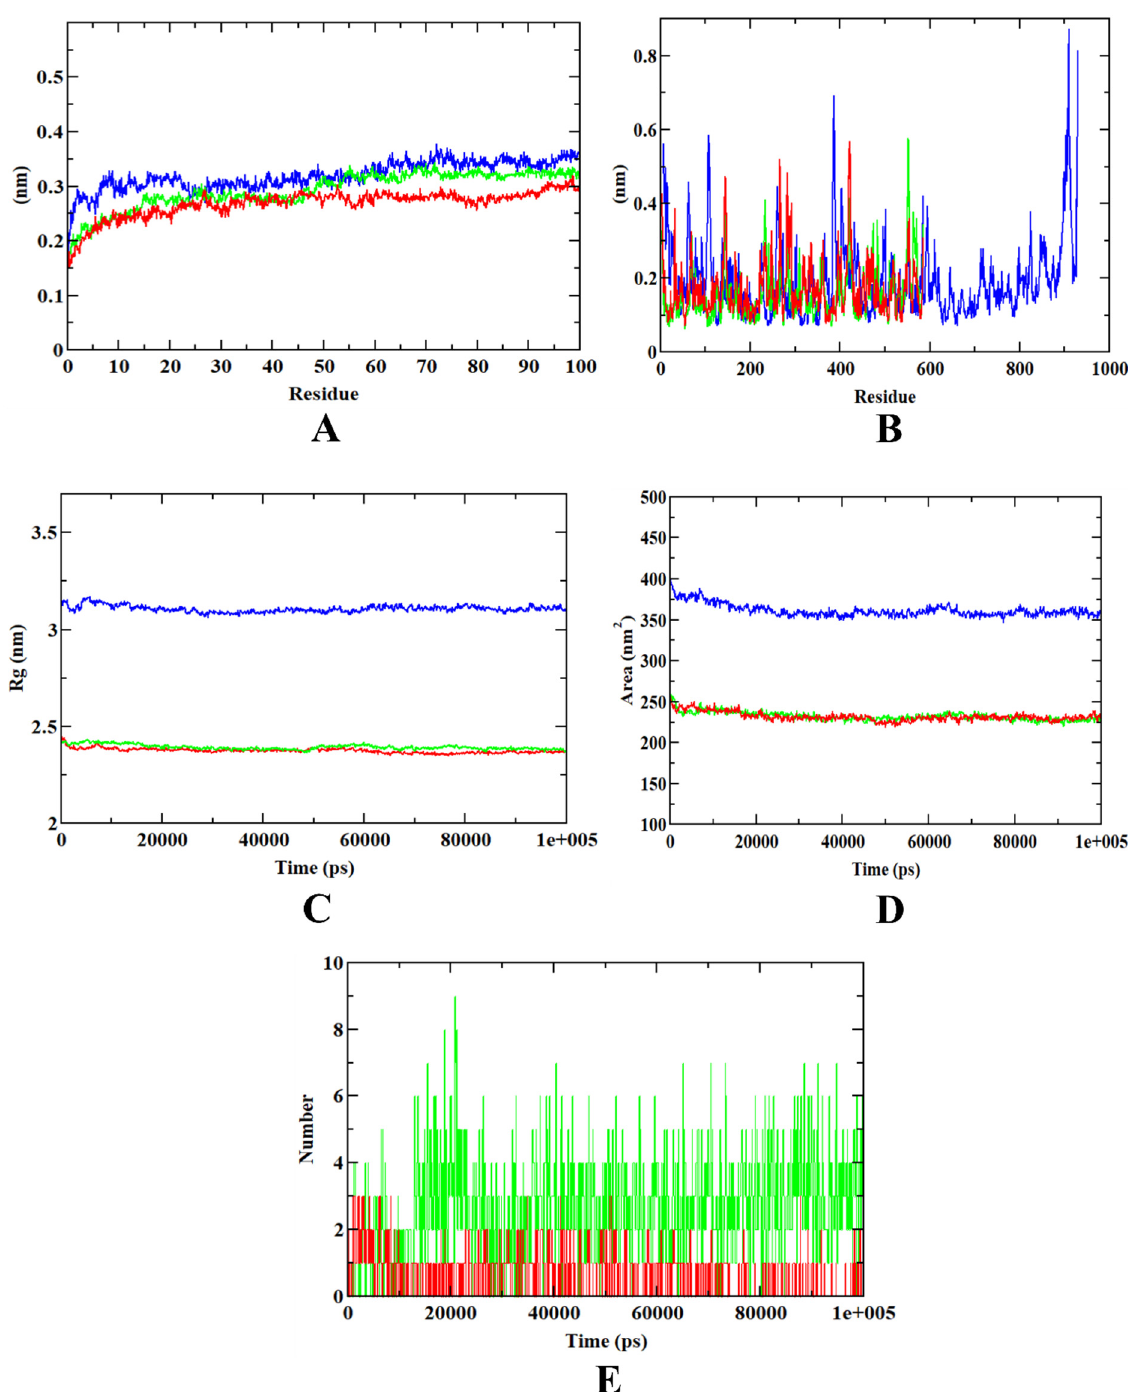
Figure 6. Visualization of the acarbose and crystal compound complexed with α -glucosidase MD simulation run for 100 ns; ( A ) RMSD; ( B ) RMSF; ( C ) Rg; ( D ) SASA; and ( E ) ligand hydrogen bonds. Blue: protein backbone atoms; red: protein–acarbose complex; green: protein–molecule complex.